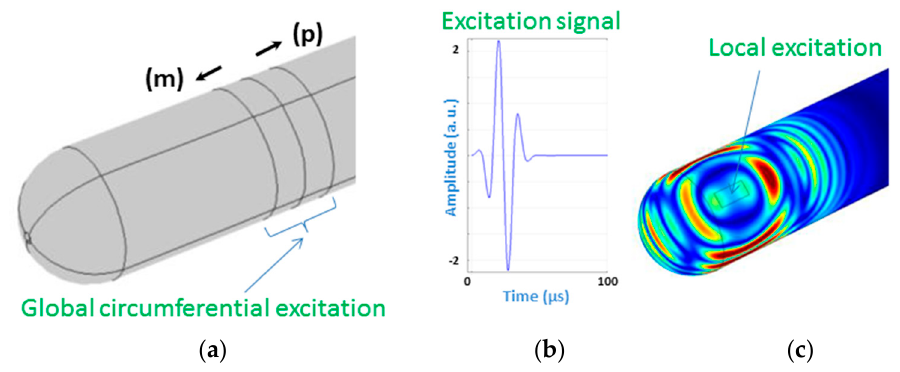
Figure 10. Transducer excitation: circumferential global excitation ( a ); the signal time of excitation ( b ) used for both excitations and local excitation ( c ). Note that the circumferential excitation consists of two parts where one is excited by the same signal ( b ) but shifted by a quarter of the main period.